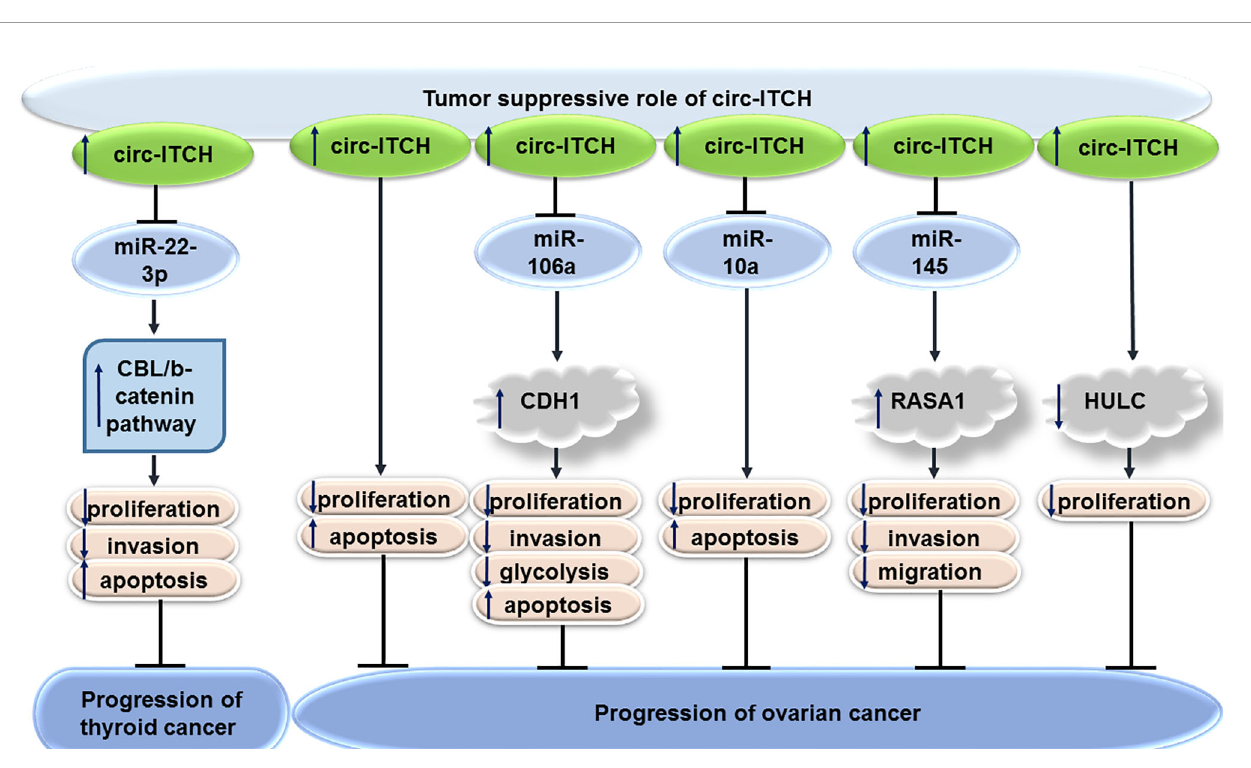
FIGURE 2 | Tumor suppressor role of circITCH in thyroid and ovarian